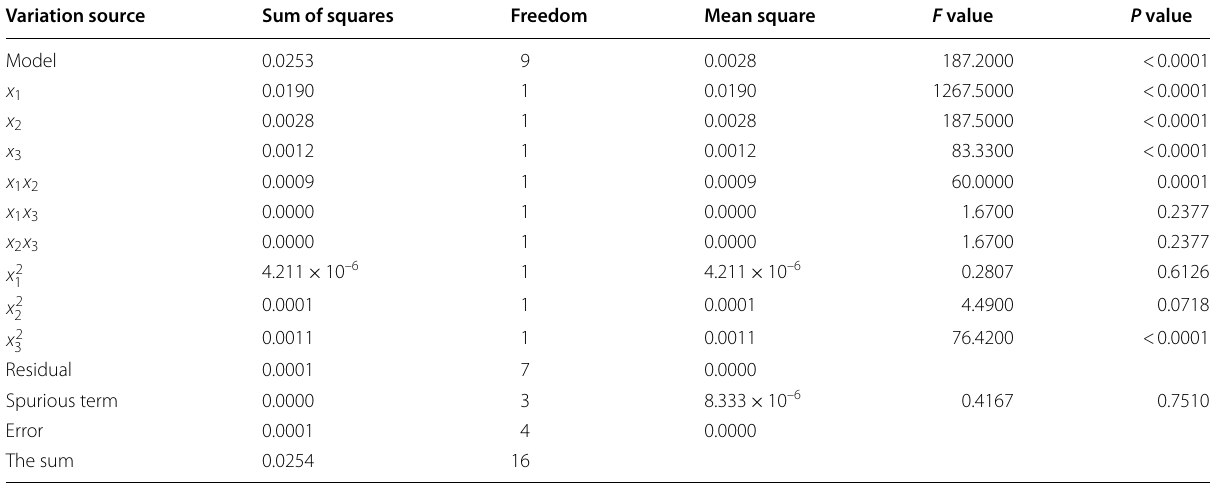
Table 4 Variance analysis of kerf width regression model Variation